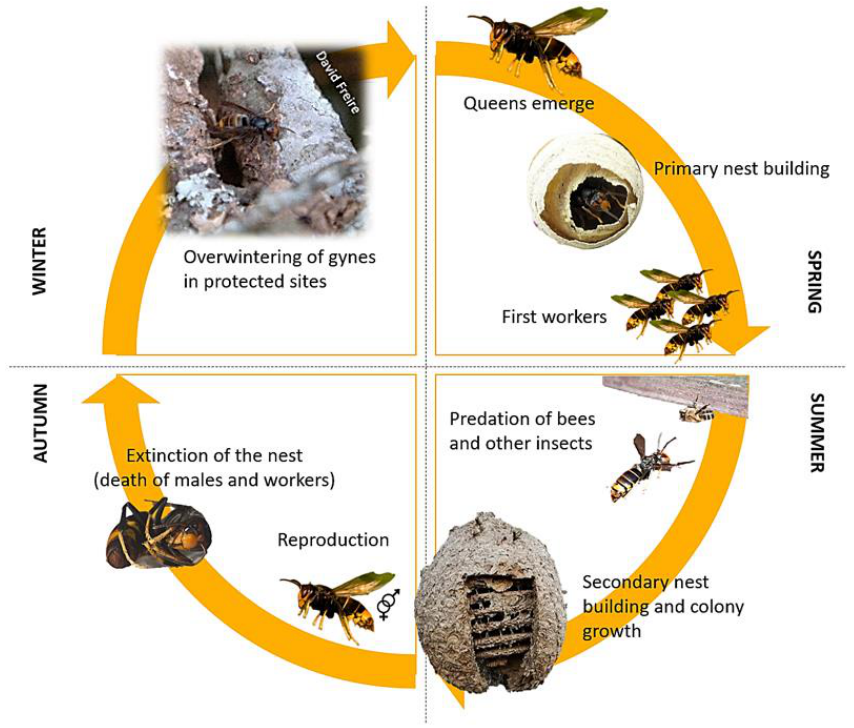
Figure 1. Life cycle of Vespa velutina hornet.